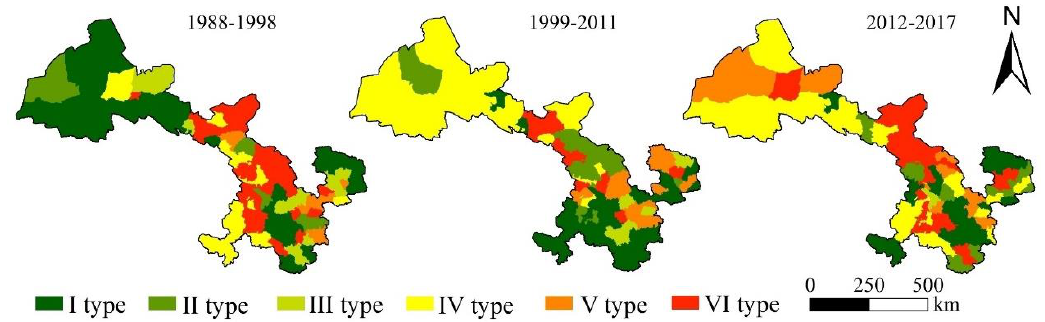
Figure 6. Spatial patterns of agricultural development types in Gansu Province in 1988–2017.